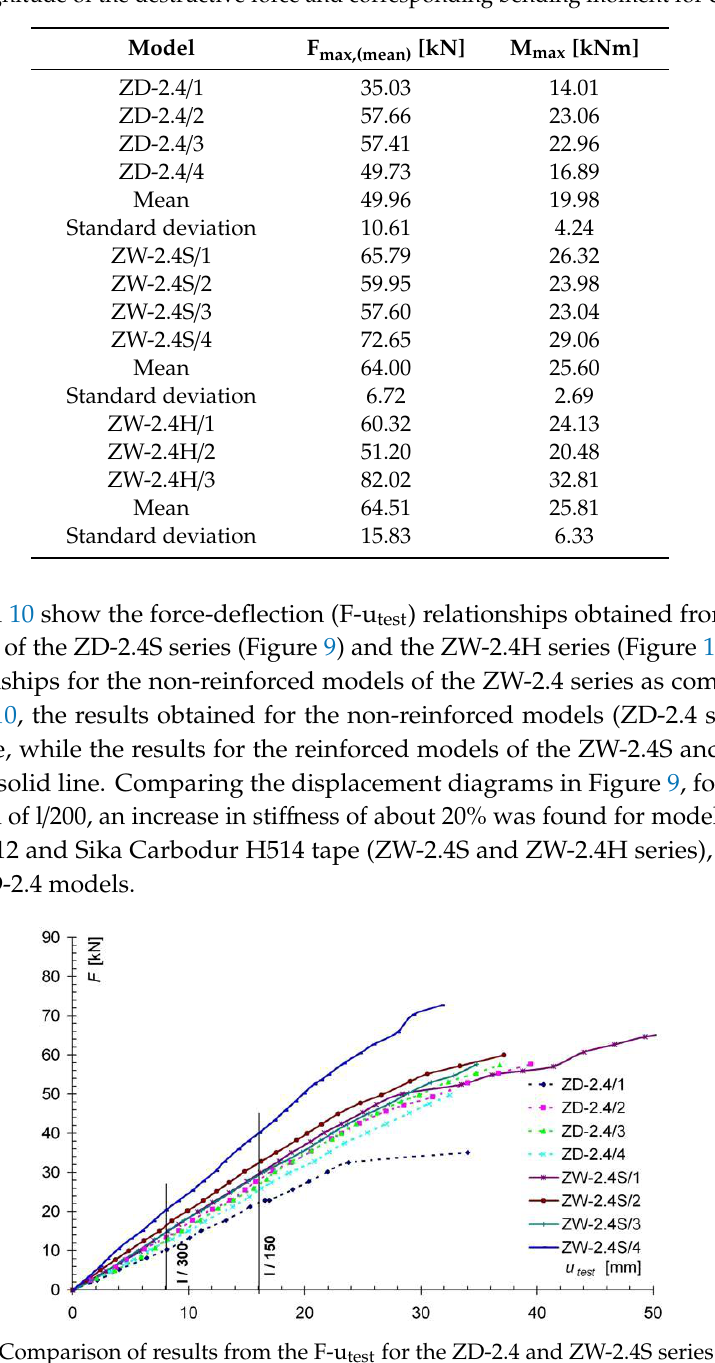
Table 2. Magnitude of the destructive force and corresponding bending moment for each model.